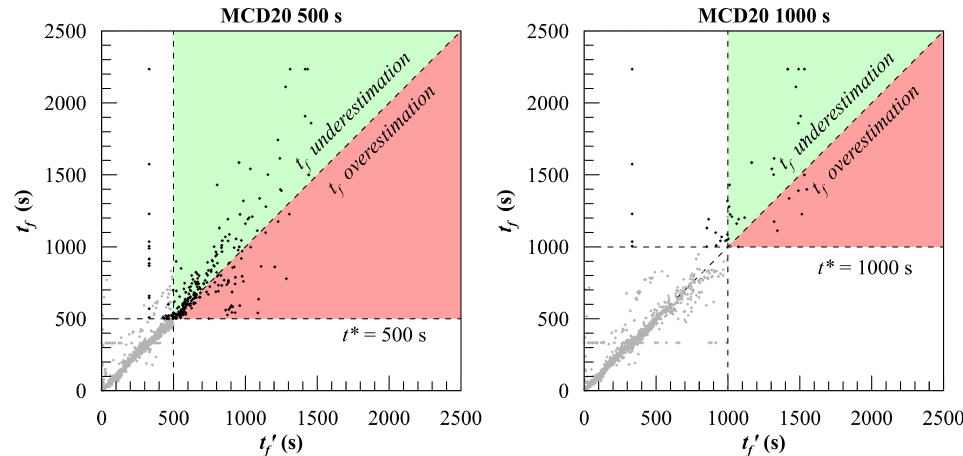
Figure 11. Predicted over observed values of the time-to-flood computed at t ∗ = 500 s and t ∗ = 1000 s. Training: MCD20; validation: MC50b; method: